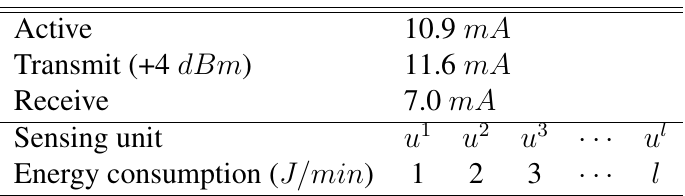
Table 3. Energy consumption model for MU-CTC problem when control and computation overheads are considered.